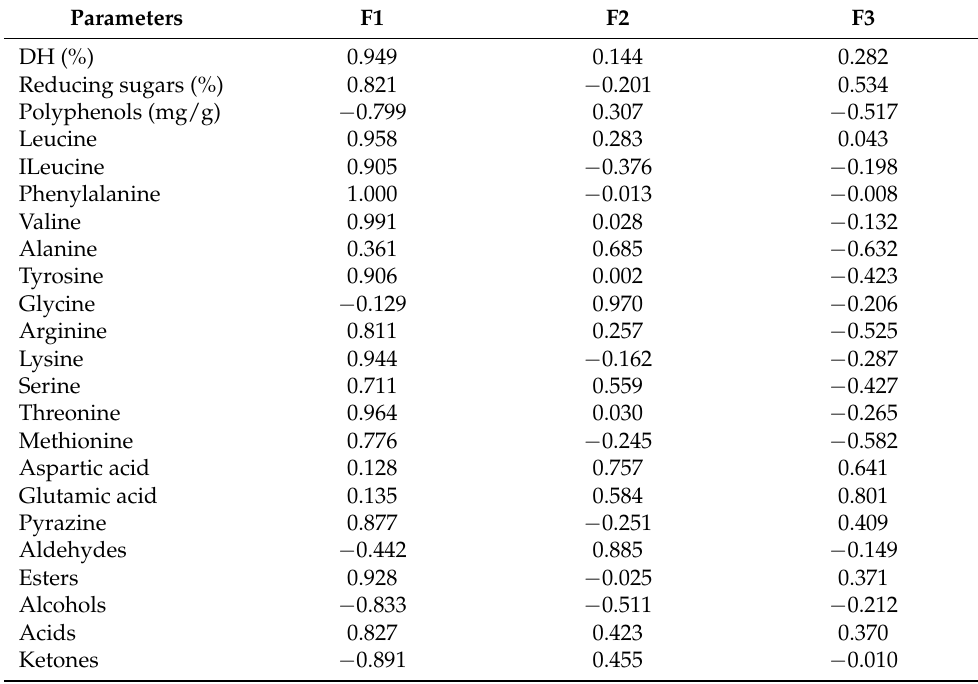
Table 5. Correlations between variables and